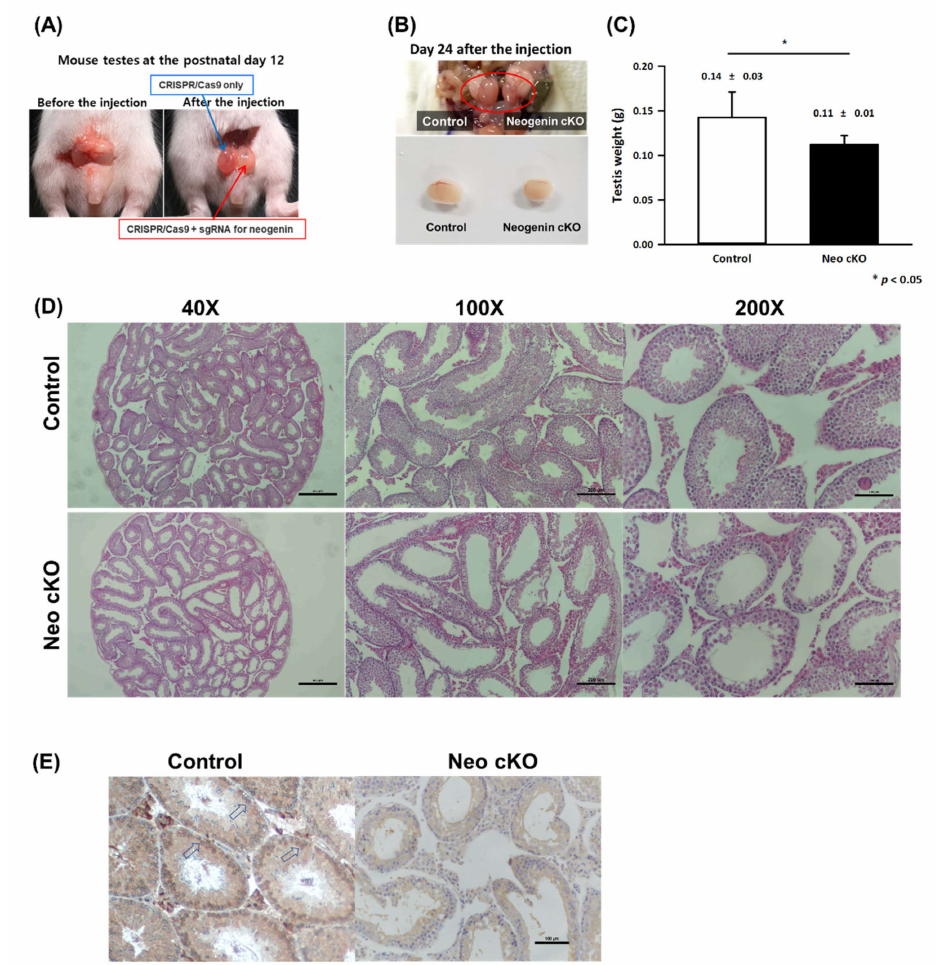
Figure 2. Morphological and cellular comparison of neogenin-cKO and sham control testes. Neogenin was conditionally knocked out in the left testis by CRISPR-Cas9 as described in the Materials and Methods, while the right testis was the sham control. ( A ) External morphology of the testes at postnatal day 12 before and after microinjection. ( B ) External morphology of the testes at 24 days after microinjection. ( C ) Both testes were surgically excised and weighed at 14 days after microinjection (n = 20). * p < 0.05 versus control by the Student’s t -test. ( D ) Hematoxylin and eosin